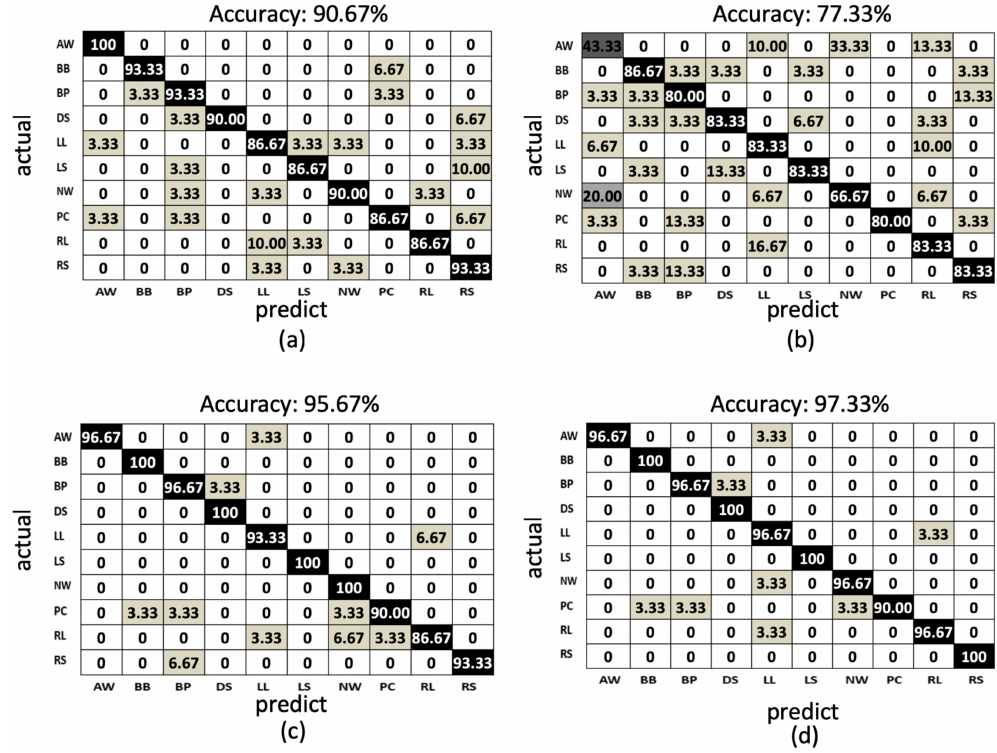
Figure 14. The confusion matrix of the LSTM-based results: ( a ) depth sensor, ( b ) gyro sensor, ( c ) accelerometer, and ( d ) decision fusion